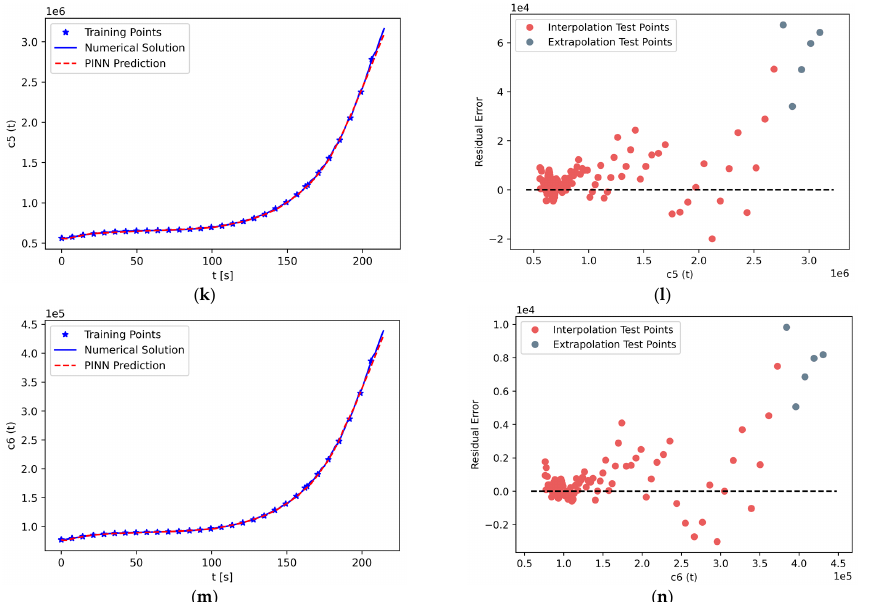
Figure 10. ( a ) Solution of neutron density concentration, 𝑛(𝑡) , in the time interval 𝑡 ∈ (cid:4670)0,217(cid:4671)𝑠 , along with PINN prediction. ( b ) Residual error plot of 𝑛(𝑡) , which shows the error margin of the predictions. ( c , e , g , i , k , m ) Solutions of delayed neutron precursor density concentration of 𝑐 (cid:2869) (𝑡) , 𝑐 (cid:2870) (𝑡) , 𝑐 (cid:2871) (𝑡) , 𝑐 (cid:2872) (𝑡) , 𝑐 (cid:2873) (𝑡) , and 𝑐 (cid:2874) (𝑡) , respectively, in the time interval 𝑡 ∈ (cid:4670)0,217(cid:4671)𝑠 , along with PINN prediction. ( d , f , h , j , l , n ) Residual error plot of 𝑐 (cid:2869) (𝑡) , 𝑐 (cid:2870) (𝑡) , 𝑐 (cid:2871) (𝑡) , 𝑐 (cid:2872) (𝑡) , 𝑐 (cid:2873) (𝑡) , and 𝑐 (cid:2874) (𝑡) , respec- tively. The training data for interpolation are in the time interval 𝑡 ∈ (cid:4670)0,207(cid:4671)𝑠 , whereas the training data for extrapolation are in the time interval 𝑡 ∈ (cid:4670)208,217(cid:4671)𝑠 . The percentage error of extrapolation predictions for the first, second, and third cases are presented in Tables 4, 5, and 6, respectively. Case 1 has the lowest prediction errors.